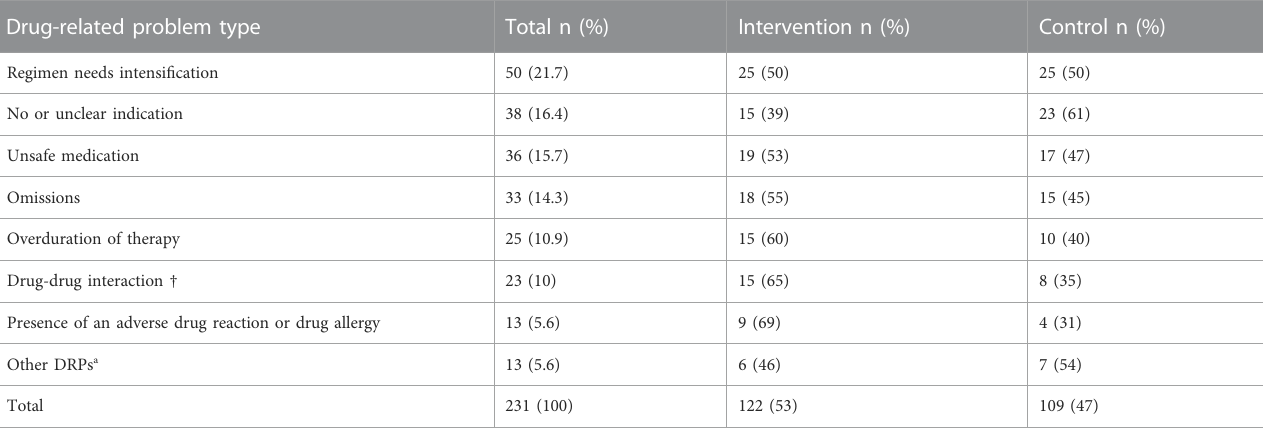
TABLE 4 List and number of drug-related problems ( N = 231).